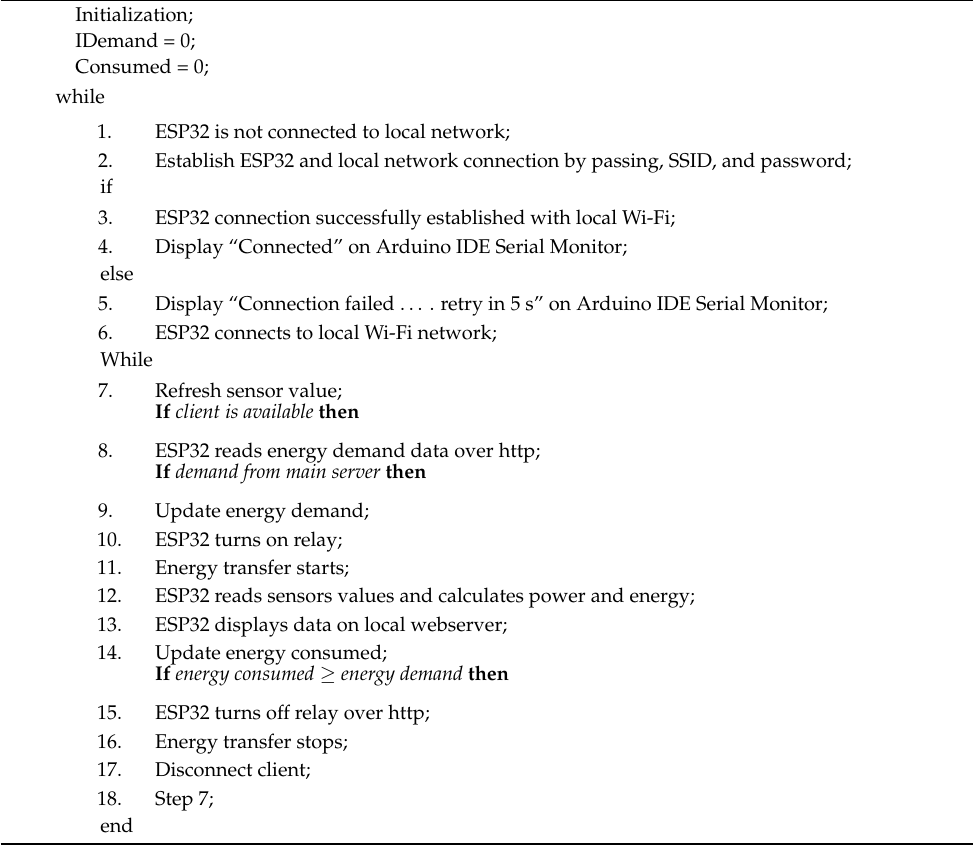
Algorithm 1 : Energy trading, data acquisition, and energy data